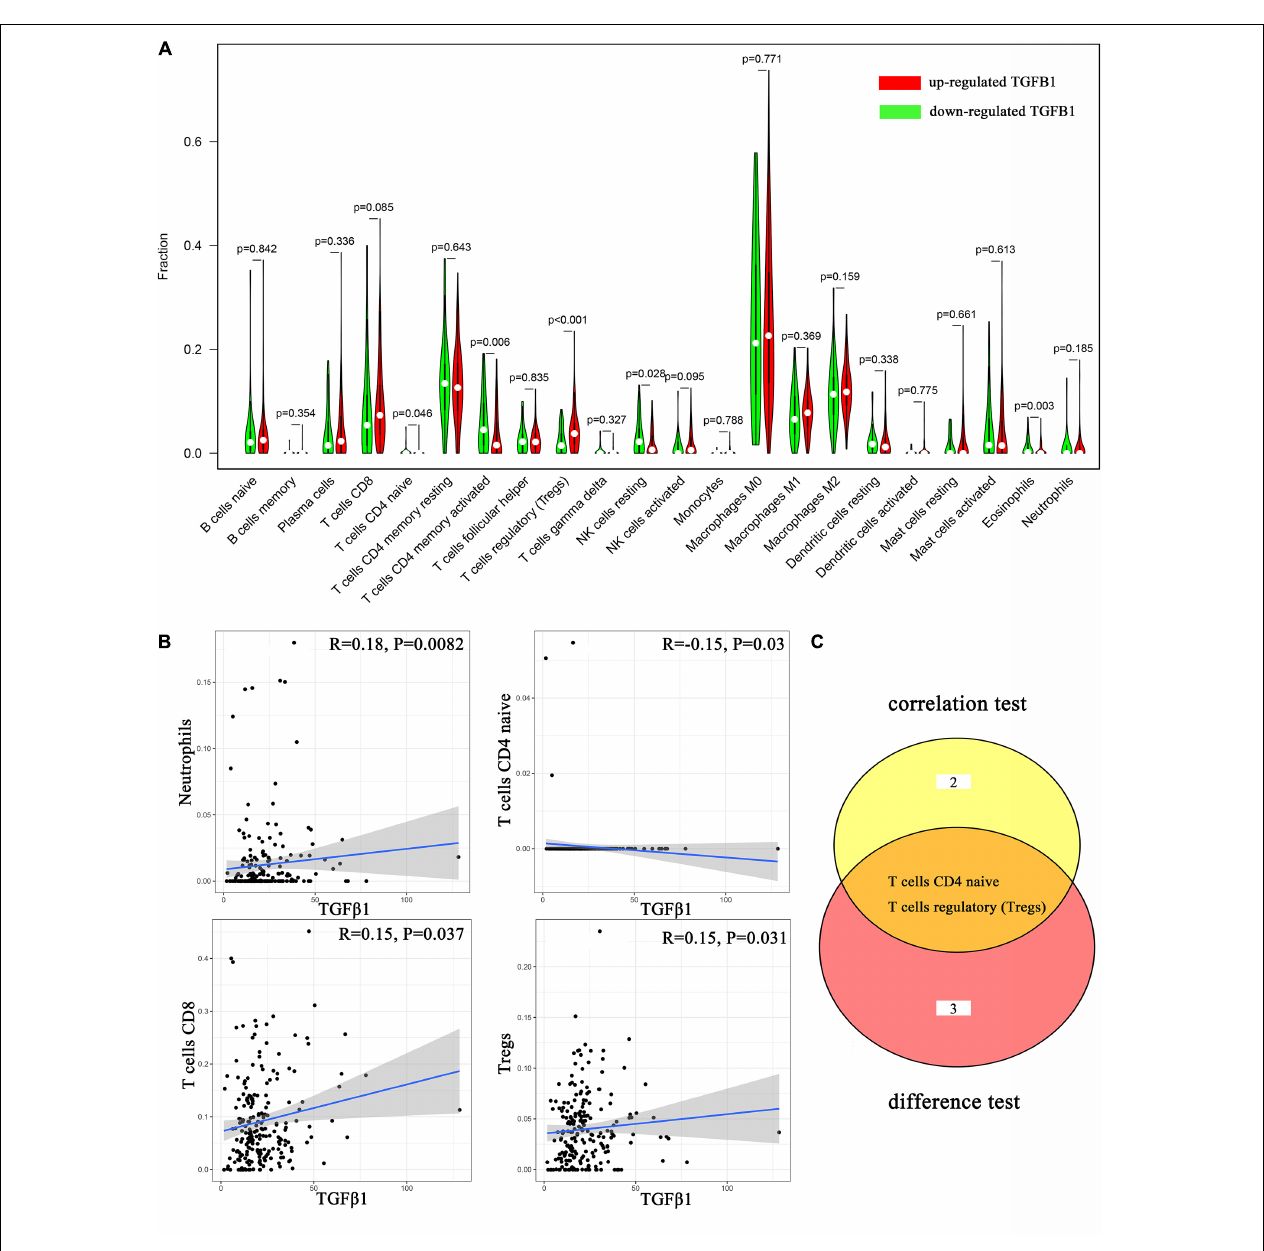
FIGURE 8 | Correlation analysis between TICs and TGF β 1. (A) Violin plot displays the differentiation of 22 kinds of TICs between colon cancer samples with high or low expression of TGF β 1; Wilcoxon rank sum was carried out for the significance test. (B) Scatter plot displays the association between 4 kinds of TICs and the expression of TGF β 1; Pearson coefficient was carried out for the correlation test; p < 0.05 was considered as the significance threshold and plotted. (C) Venn plot displays two kinds of TICs shared by difference and correlation tests showed in violin and scatter plots,